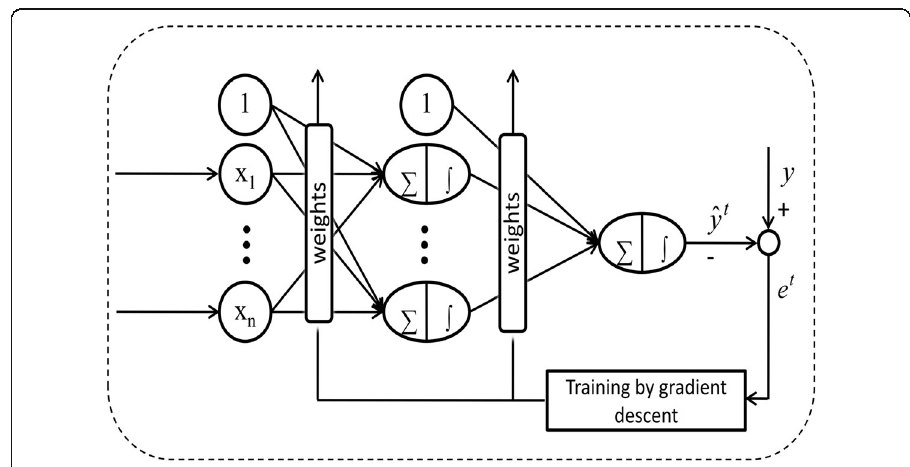
Fig. 1 Multilayer perceptron based forecasting